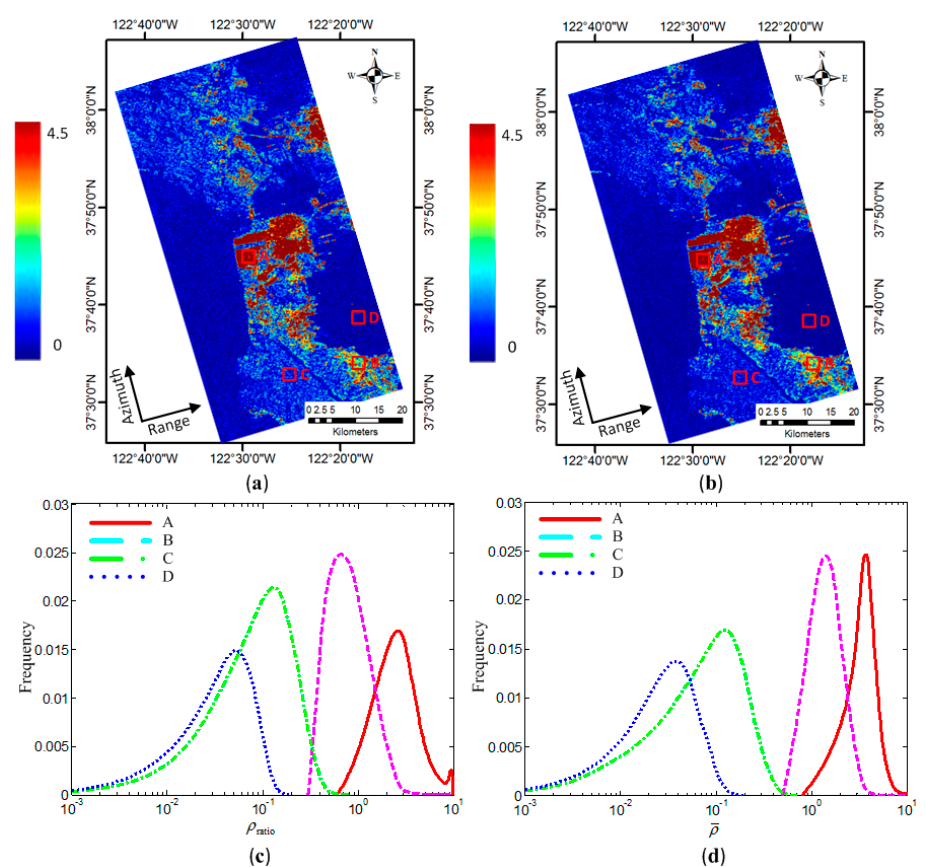
Figure 7. The proposed coherence coefficient ratio: ( a ) (cid:2025) (cid:2928)(cid:2911)(cid:2930)(cid:2919)(cid:2925) ; ( b ) (cid:2025)̅ ; and ( c , d ) histograms of the four selected patches in ( a , b ), respectively.